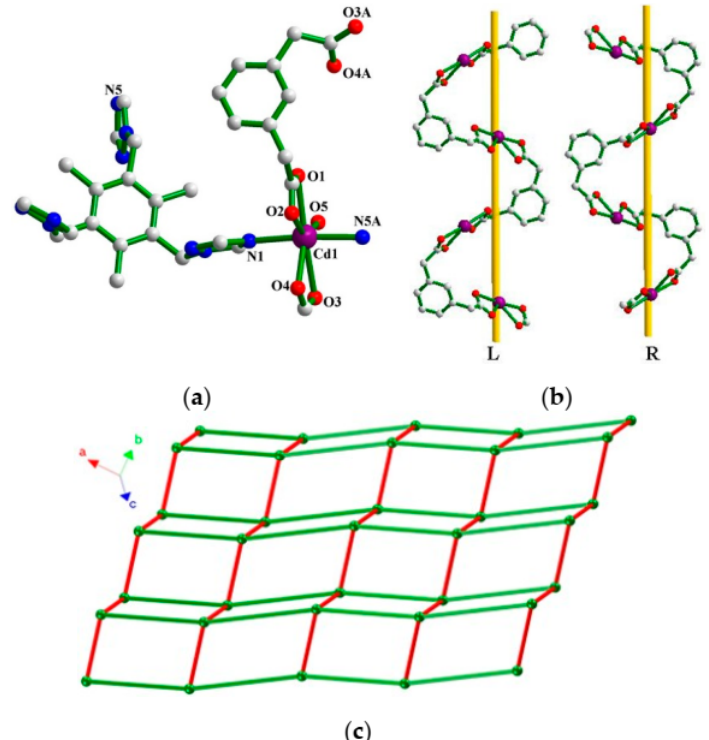
Figure 2. ( a ) Coordination environment of Cd(II) ions in 2 with hydrogen atoms omitted for clarity. ( b ) The right- and left-handed helical chains built by Cd(II) ions and m -phda 2 − ligands. ( c ) View of the 2D ladder-like sheet with 4 4 topology (green ball: Cd II ; Red line: m -phda 2 − ; green line: